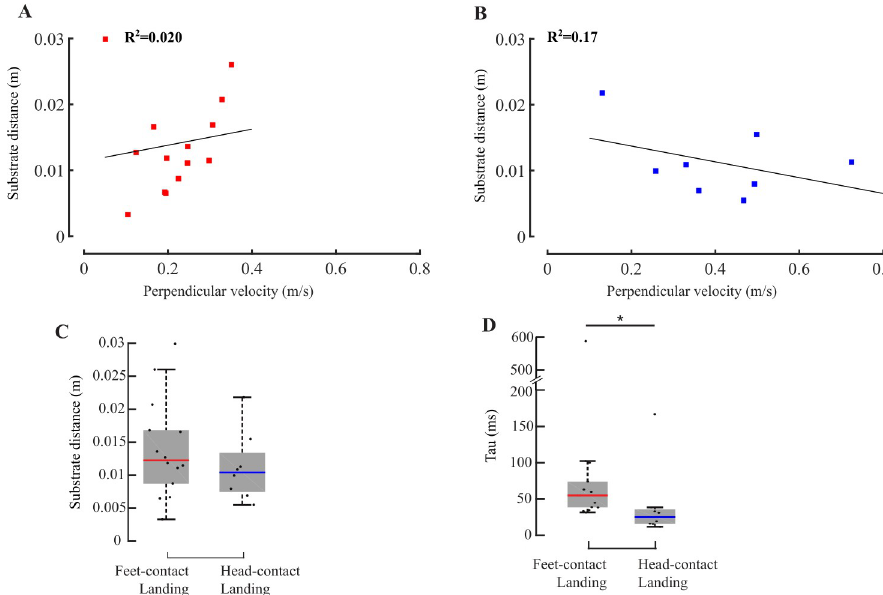
Fig 4. Onset of leg-extension for feet-contact and head-contact ceiling landings. Of the 22 flies which extended their legs when during ceiling landing (see Materials and methods), 14 executed a feet-contact and 8 a head-contact landing. (A) Substrate distance versus perpendicular velocity at the onset of leg-extension for feet-contact landings (n = 14; R 2 = 0.020). (B) Substrate distance versus perpendicular velocity at onset of leg-extension for head-contact ceiling landings (n = 8, R 2 = 0.17). (C-D) Box plots for (C) substrate distance, and (D) tau , at the onset of leg-extension for feet-contact and head-contact